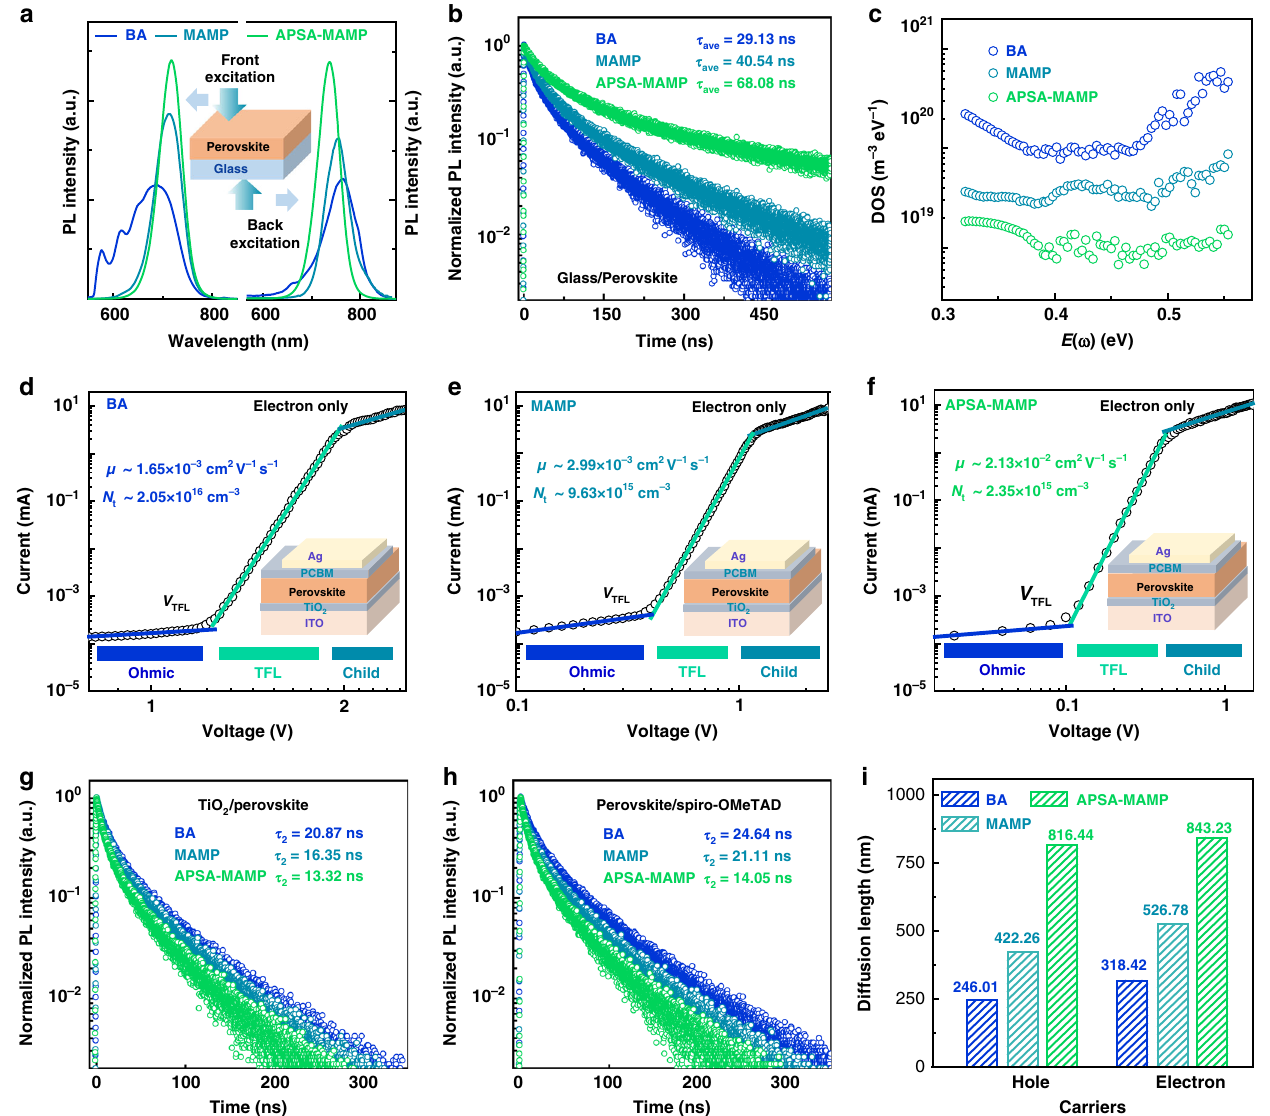
Fig. 4 Optoelectronic properties of quasi-2D perovskite fi lms. a Steady-state PL spectra of quasi-2D perovskite fi lms excited from the front and back sides (as illustrated in the inset). b TRPL decay traces for three fi lms based on glass substrate. c TAS analysis of three quasi-2D perovskite fi lms. SCLC curves of d (BA) 2 (MA) 3 Pb 4 I 13 , e pristine, and f APSA-treated (MAMP)MA 3 Pb 4 I 13 fi lms, respectively. TRPL decay traces for three perovskites fi lms covered with g TiO 2 and h Spiro-OMeTAD layers. i Carrier diffusion length for both electron and hole was calculated from the optical